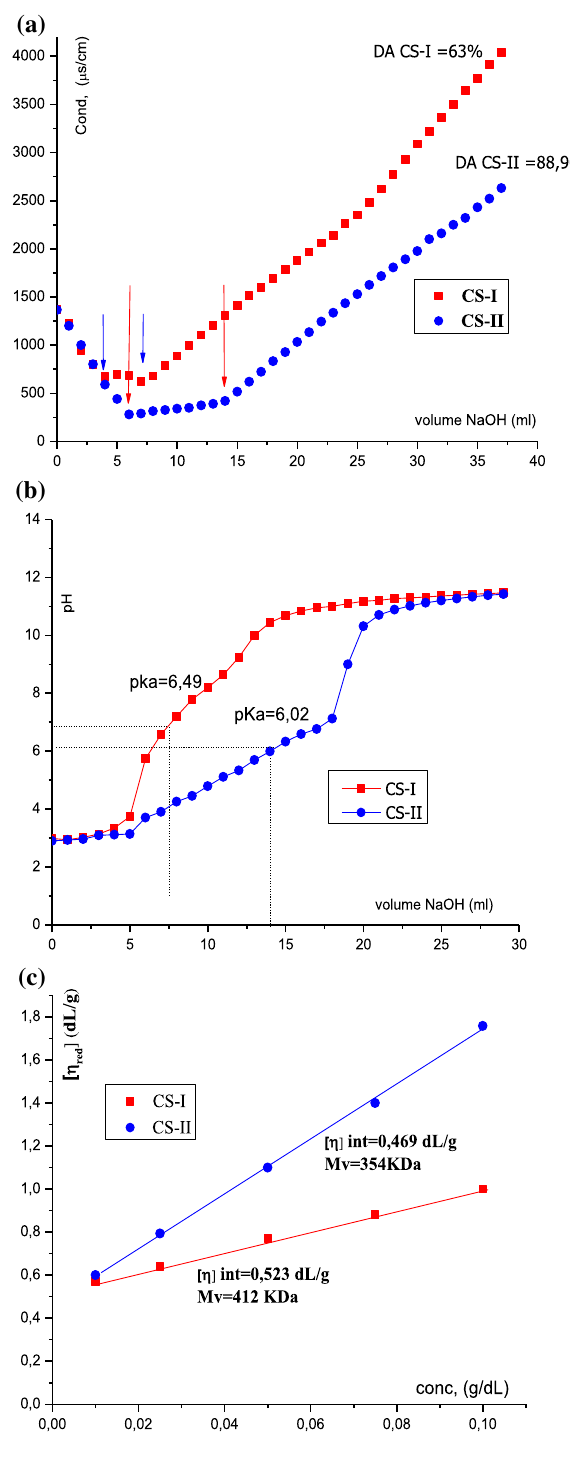
Fig. 3 Determination of DA of CS-I and CS-II by a conductometric measurements, b pH metric measurements, c determination of Molec- ular weight by viscosimetry measurements ( T = 30